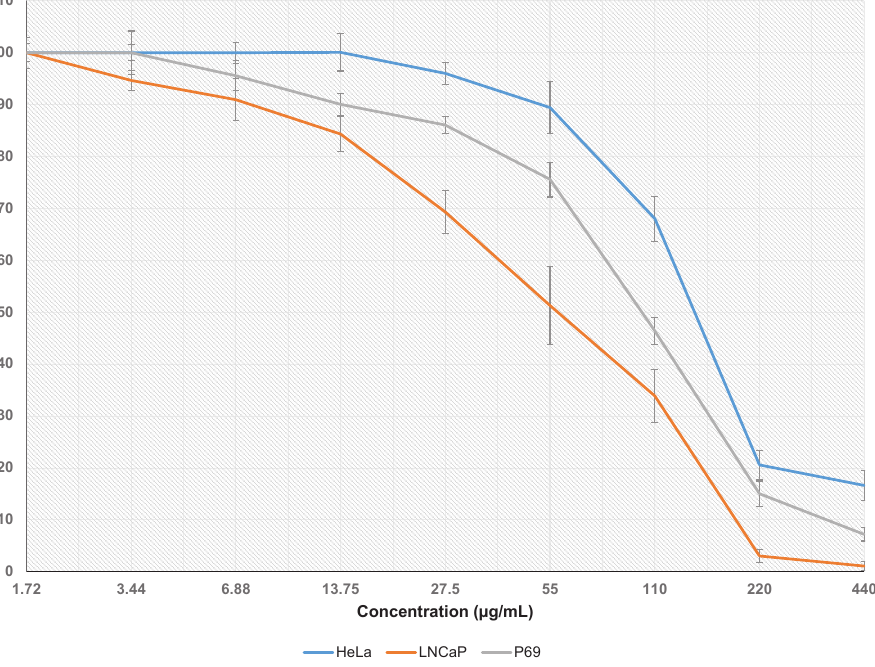
Figure 4: Dose-dependent anti-proliferative activity of Cymbopogon nardus essential oil. HeLa, LNCaP and P69 cells were treated for 72 h. Experiments were performed three times in sextuplicate.